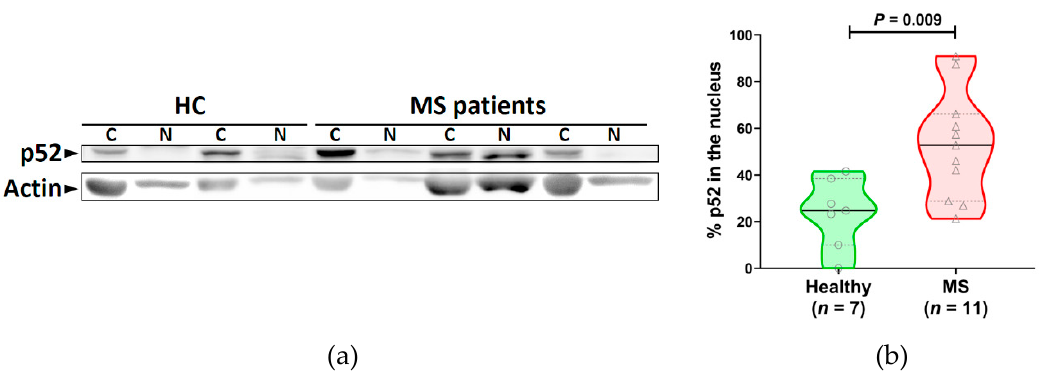
Figure 5. The percentage of total p52 found in the nucleus is significantly increased in MS patients compared to healthy individuals. (a) Representative blot of p52 and actin in cytoplasmic (C) and nuclear (N) fractions of cells from healthy subjects and MS patients. (b) Summary of the percentage of the total amount of p52 in the nucleus. In the violin plots, a solid line indicates the median, and dotted lines show the interquartile range. Analyzed by two-tailed Mann–Whitney U test.